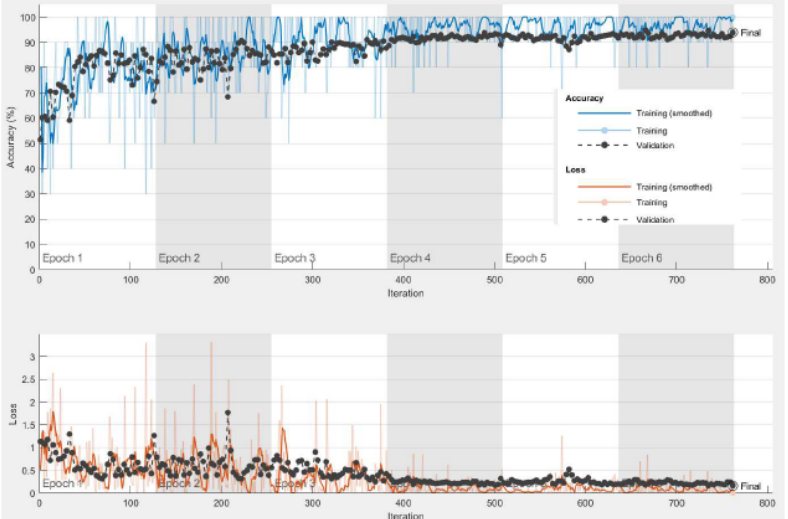
Figure 12. Training progress curve for InceptionResnetv2 model with image SR using dataset #2. Table 8. Results for pre-trained-MCSVM-based models with image SR using dataset #2. Models